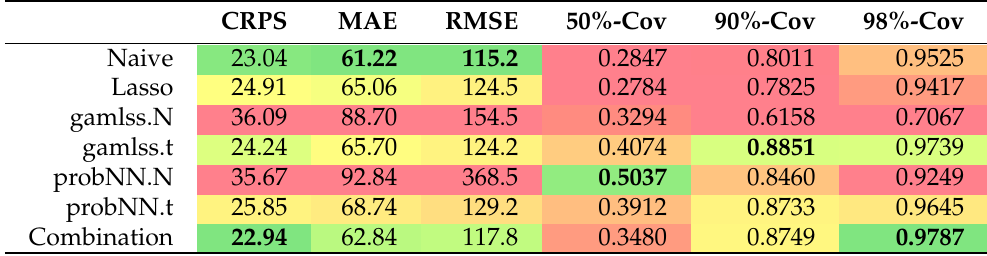
Table 1. Error measures of the considered models. Colour indicates the performance columnwise (the greener, the better). With bold, we depicted the best values in each